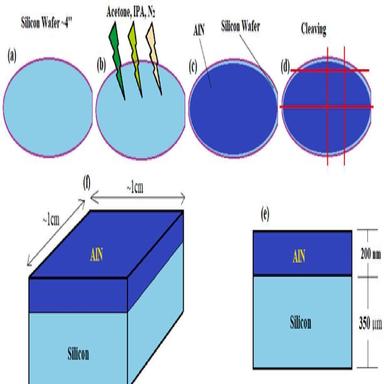
Fabrication processes of AlN/Silicon substrate; (a) Silicon Wafer, (b) Cleaning protocols for Silicon Wafer, (c) Deposition of AlN on Silicon Wafer, (d) Cleaving of AlN/Silicon Wafer, (e) 2D-view of cleaved sample, (f) 3D-view of cleaved sample.